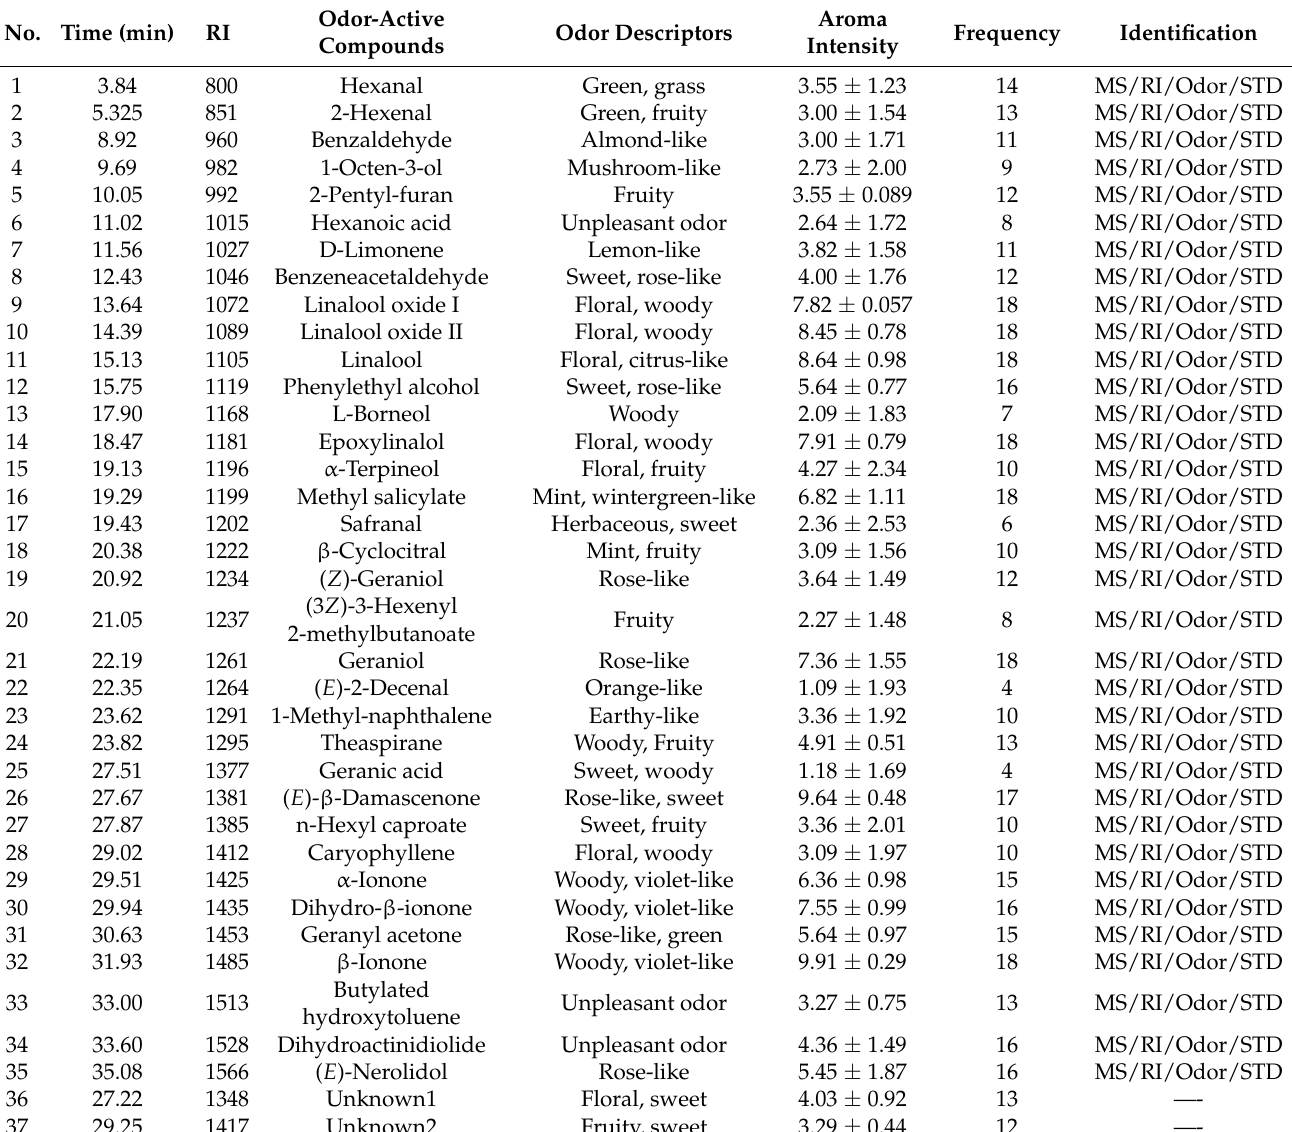
Table 1. Odor-active compounds detected by GC-O and GC-MS in sun-dried black tea samples (11